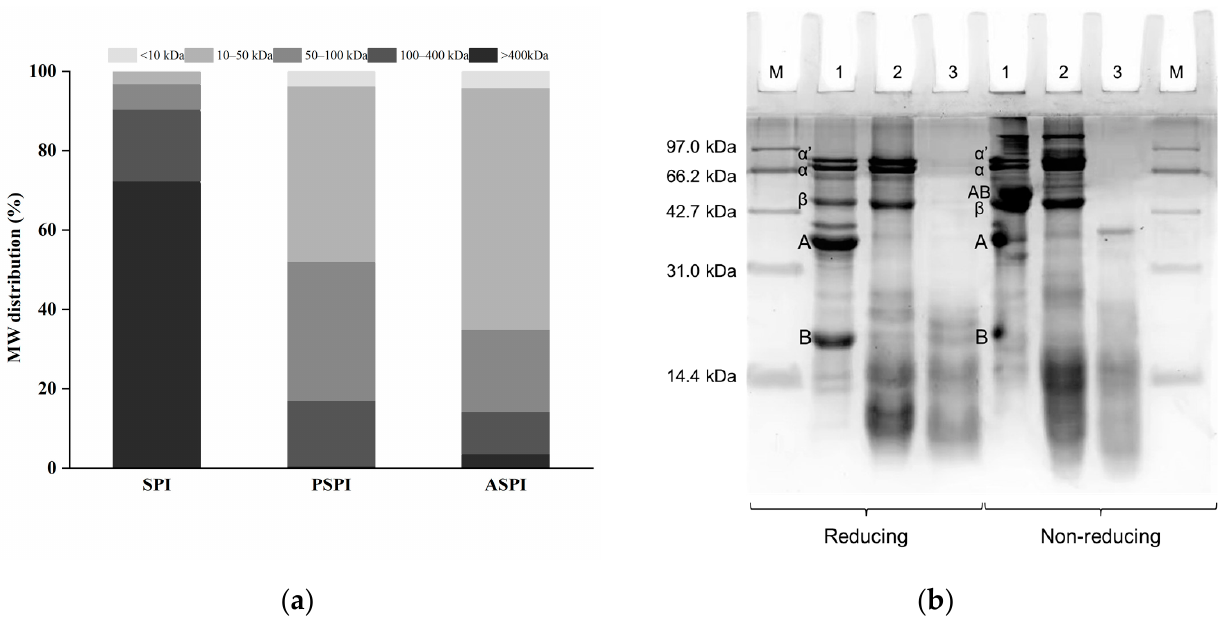
Figure 1. SPI, PSPI, and ASPI structural characteristics. ( a ) SPI, PSPI, and ASPI molecular weight distribution; ( b ) SDS-PAGE profiles of SPI (Lane 1), PSPI (Lane 2), ASPI (Lane 3), and a molecular mass standard (Lane M).